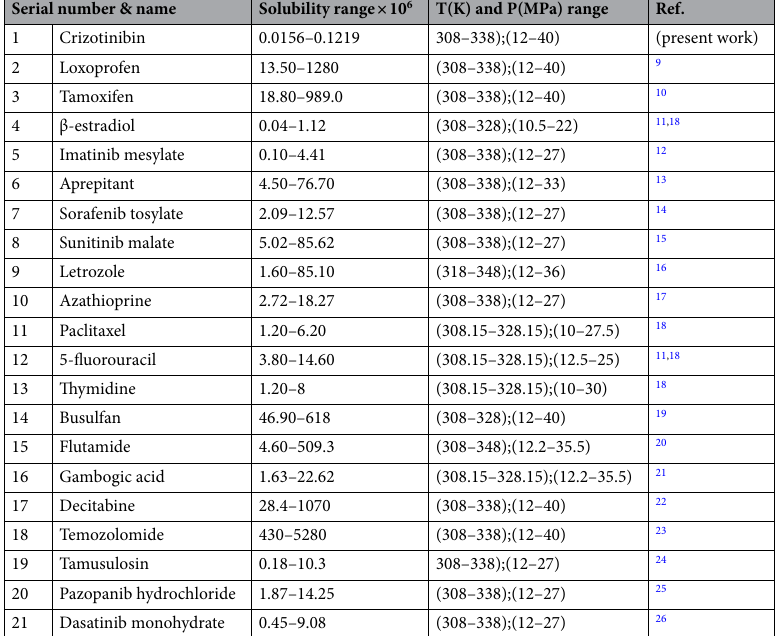
Table 3. Solubility information of the anticancer drugs.